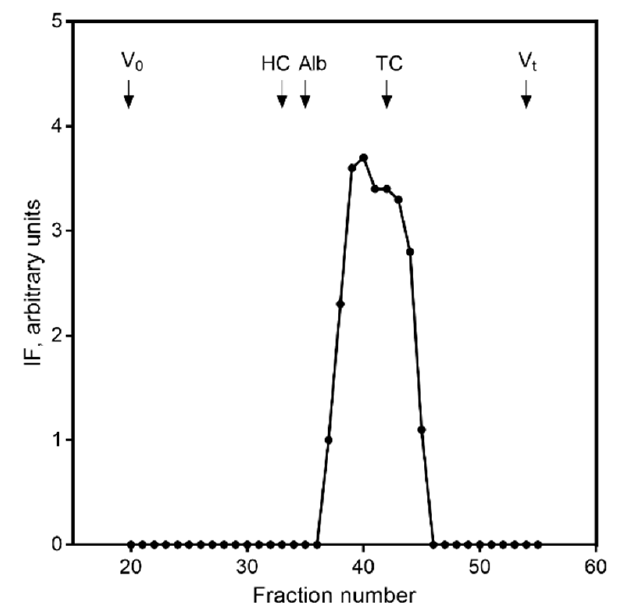
Figure 1. Presence of human IF in serum. Size exclusion chromatography of endogenous human IF in serum measured by prototype IF ELISA. X-axis indicates the fraction number. Human IF eluted in fraction 40. Elution volume for void volume (V0) (fraction 20), human HC (fraction 33), albumin (fraction 35), human TC (fraction 42), and total volume (Vt) (fraction 54) are shown by arrows for comparison. Results are given in arbitrary units.